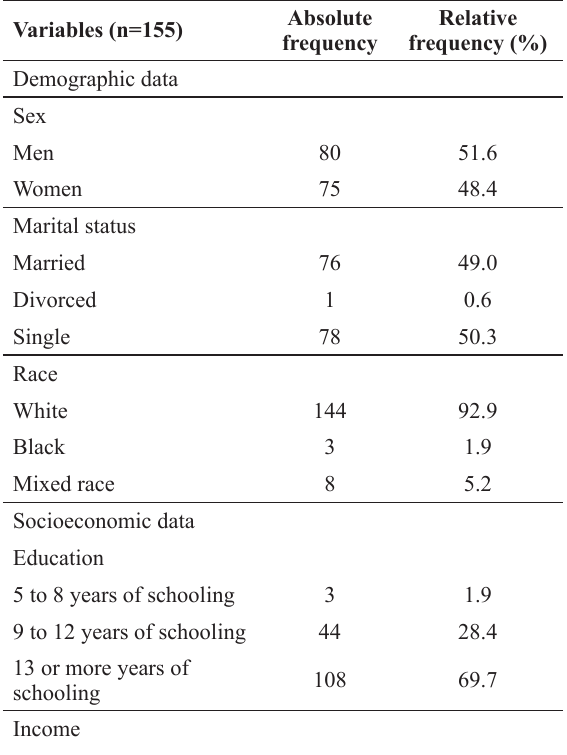
Characterization of cohort participants who underwent coronary artery tomography in